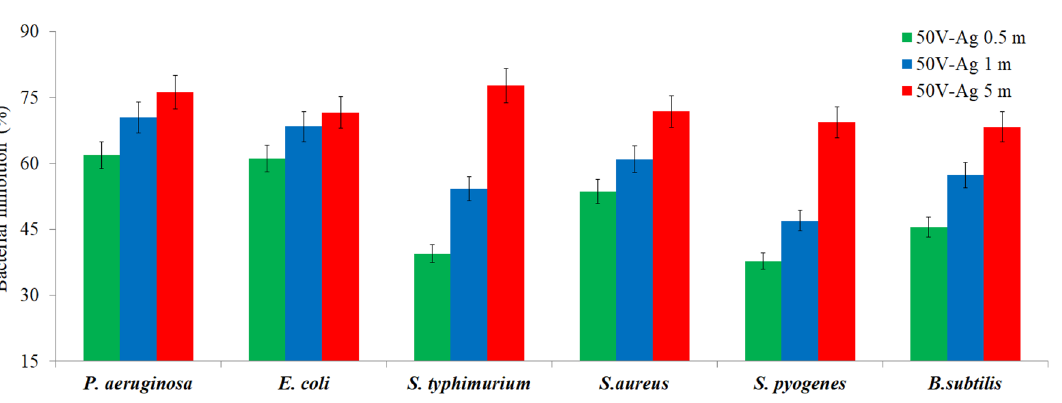
Figure 8. Percentage of bacterial inhibition of AgNPs-deposited nanotube surfaces.